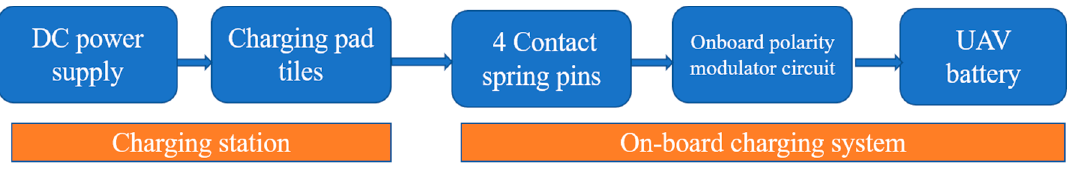
Figure 1. Main system components of the presented charging platform. UAV: unmanned aerial vehicle.